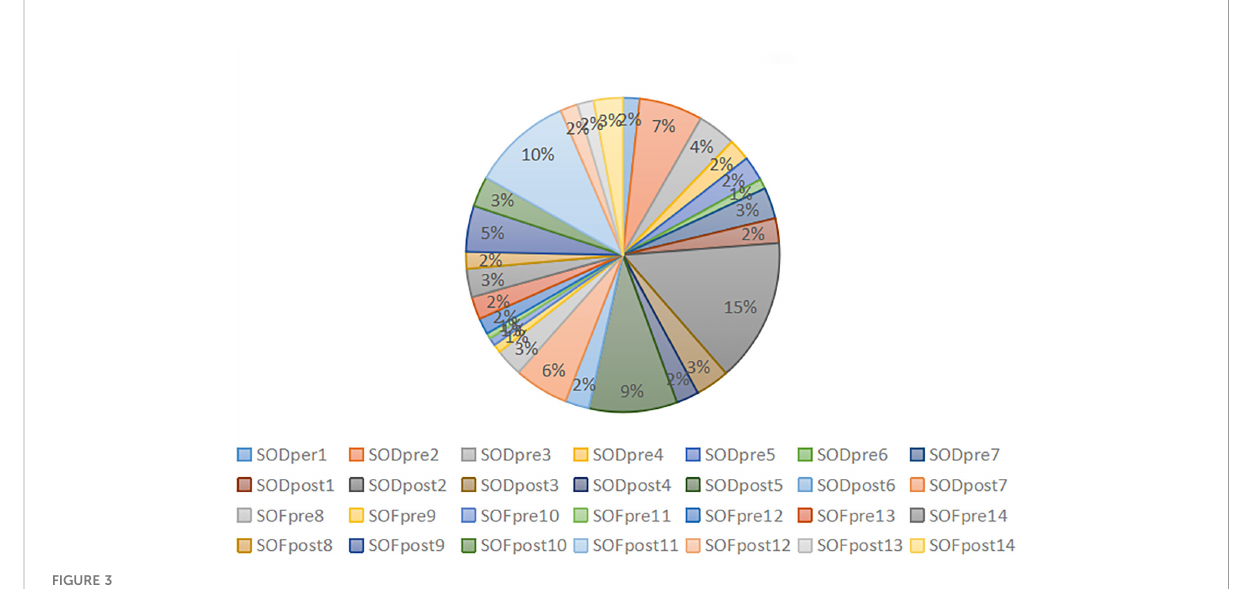
FIGURE 3 Proportion of amplicon sequence variant/operational taxonomic unit per